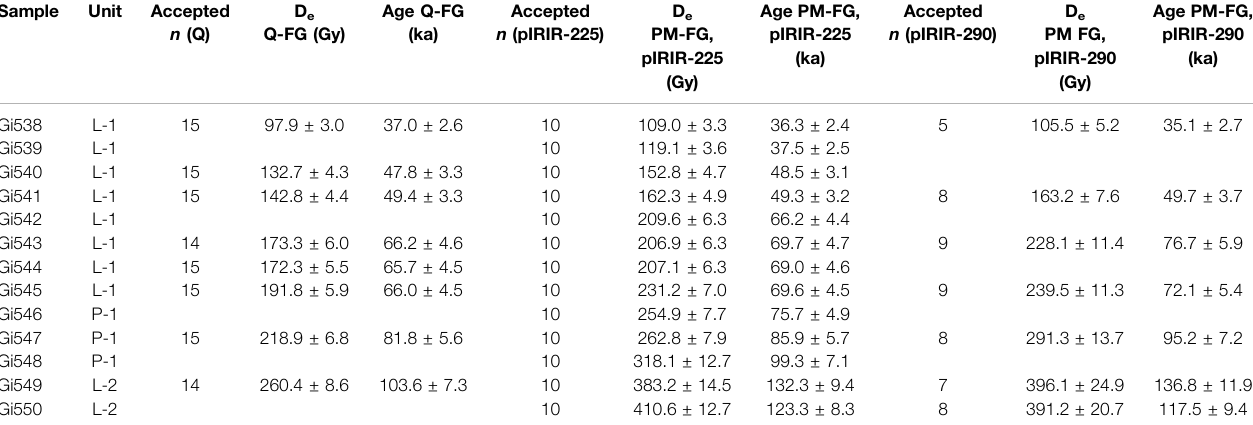
Agesderivedfrombothprotocolsarenotcorrectedforfading,andagesofthepIRIR-290protocolincludearesidualsubtractionof18.3 Gy.AllD e valuesarebasedonthearithmeticmean.